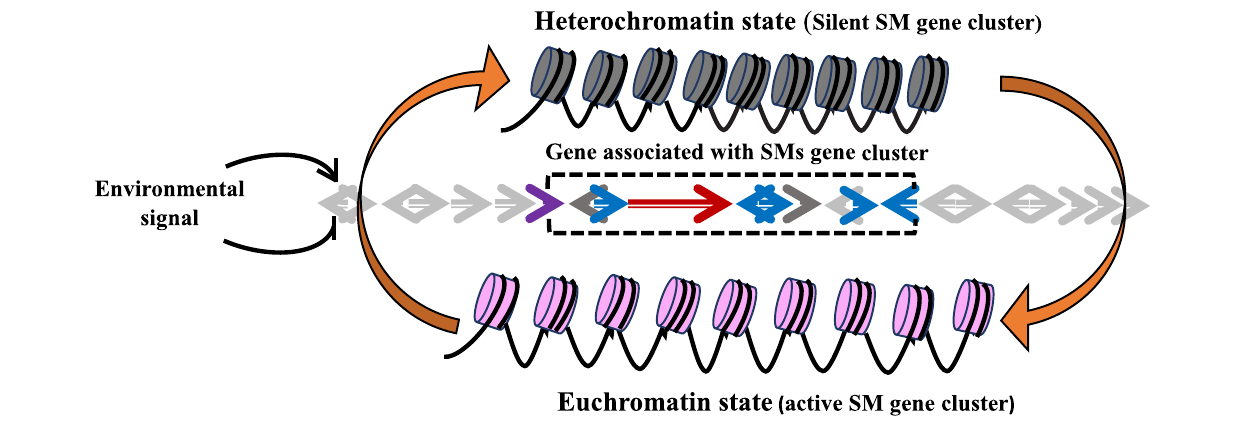
FIGURE 1 | The impact of chromatin structure on transcriptional regulation of secondary metabolite (SM) gene clusters. SM gene clusters remain in transcriptionally inactive or repressive heterochromatin state. Due to different environmental cues (light, temperature, pH, carbon, nitrogen, and iron), chromatin changes from heterochromatin state to euchromatin (transcriptionally active) state, thus activating the SM biosynthetic pathway.